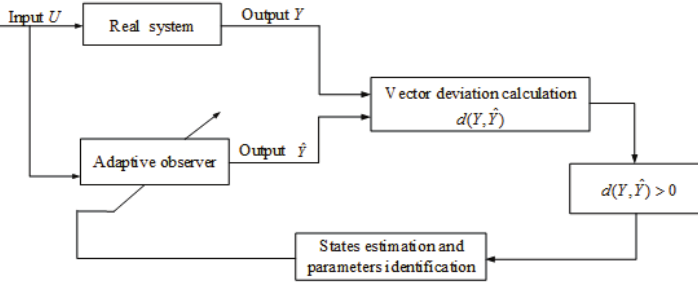
Figure 1. Dynamic observer structure block